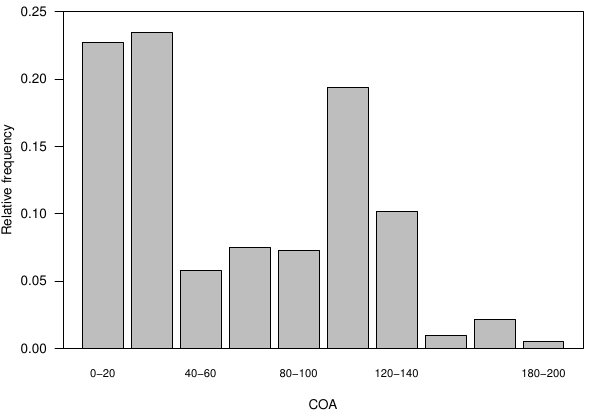
Figure A10. Relative frequency of the technical result ( TRE ) and of the company age ( COA ) of non-life undertakings. The figure presents twice the relative frequency of TRE : once sliced by billion and once sliced by million.